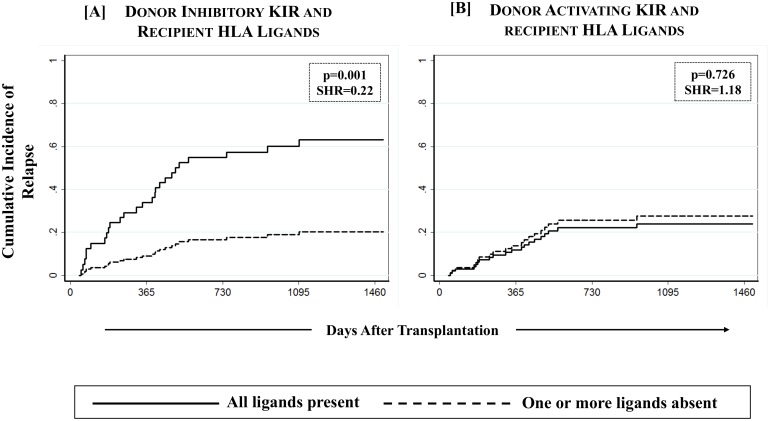
Effect of missing HLA ligands in recipients of unrelated donor HCT.Absence of one or more missing HLA ligands was scored for donor inhibitory KIR3DL2 (A3/A11), KIR3DL1 (Bw4), KIR2DL2/2DL3 (C2) and KIR2DL1 (C1) as well as activating KIR2DS1 (C2) and KIR3DS1 (Bw4). A multivariate competing risks regression analysis revealed a significantly reduced incidence of relapse (p-values <0.05) among recipients of unrelated donor HCT in which one or more HLA ligands for donor inhibitory KIR were absent.